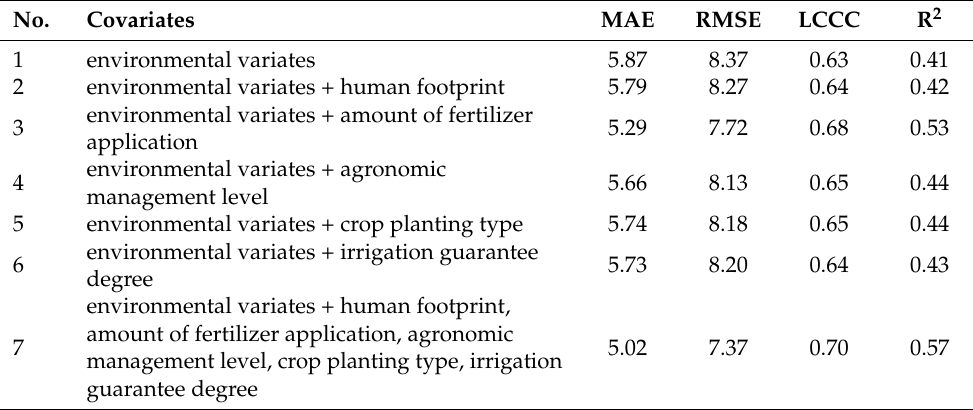
Table 4. Prediction performances of SOM for seven models.